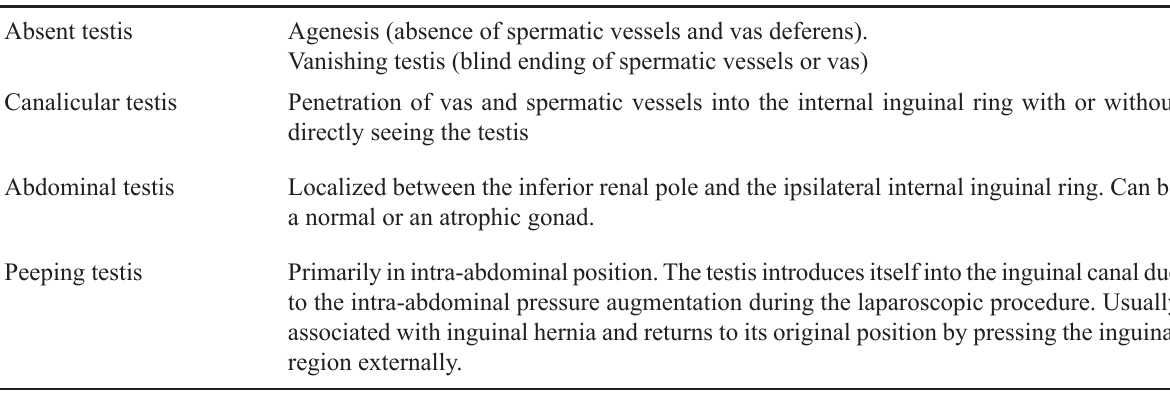
Table 2 – Laparoscopic findings classification.